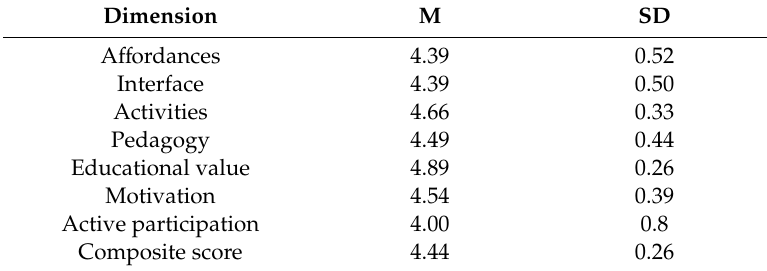
Table 2. Experimental group students’ attitudes toward the learning environment “Be smart when